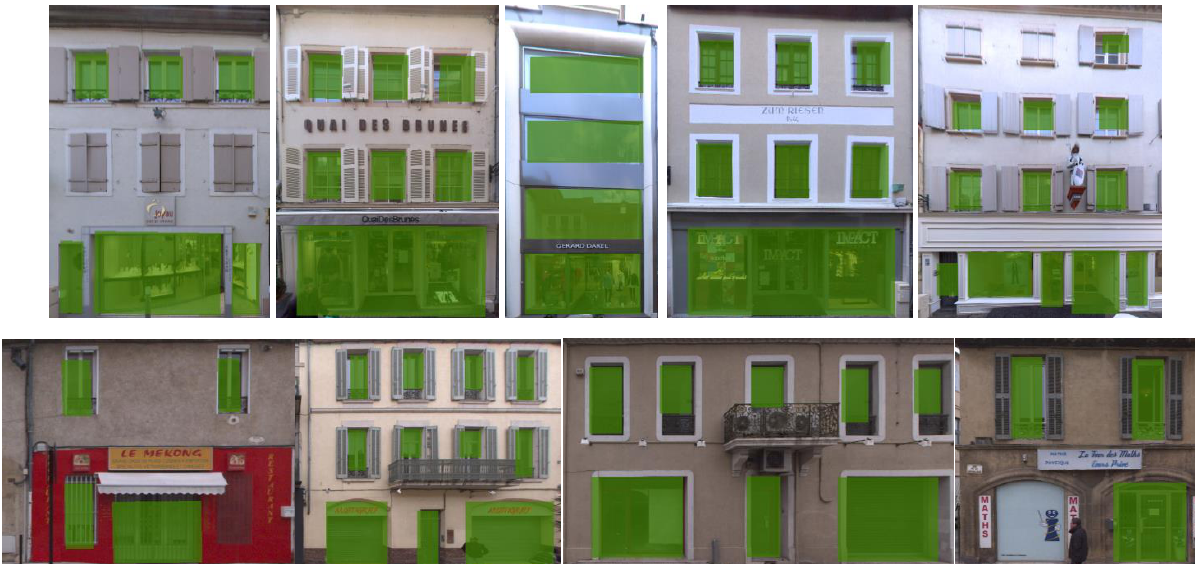
Figure 9: Examples of wall with automatic textures and detected openings in green. Top: Mulhouse. Bottom: